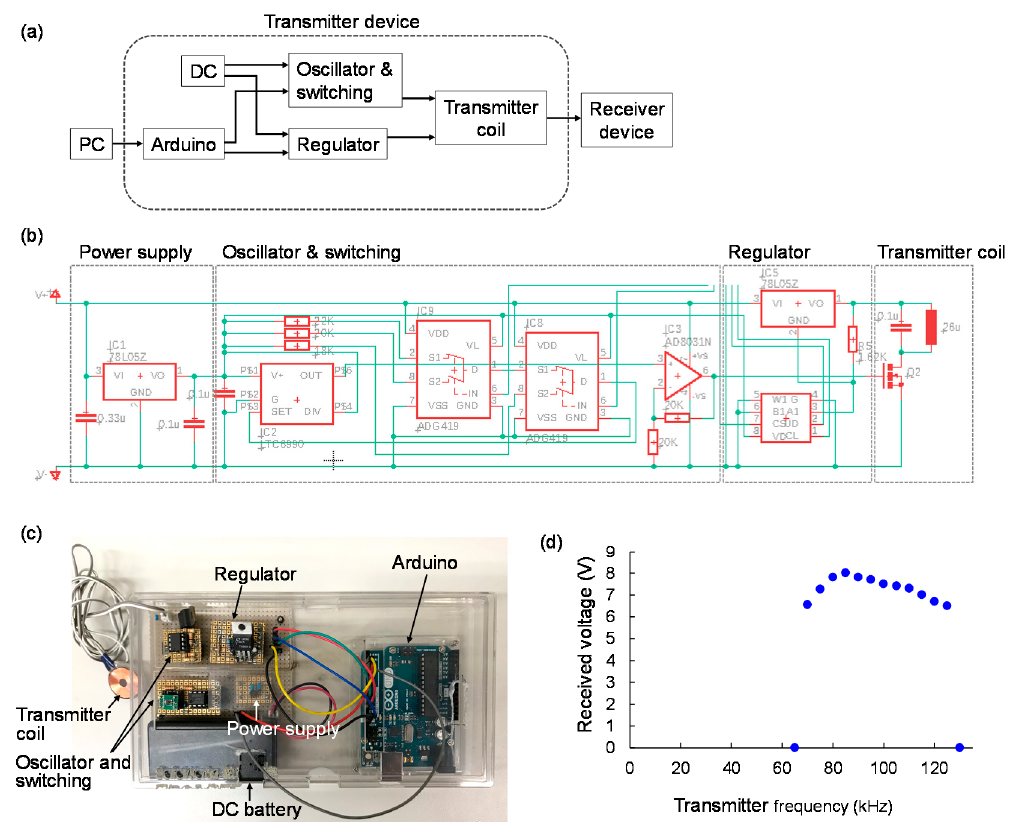
Figure 4. A transmitter device system for visual feedback control of the rat ankle angle: ( a ) A schematic of the transmitter device system; ( b ) The electrical circuit of the transmitter device; ( c ) The fabricated transmitter device; ( d ) The relationship between the transmitter frequency and received voltage on the receiver device.